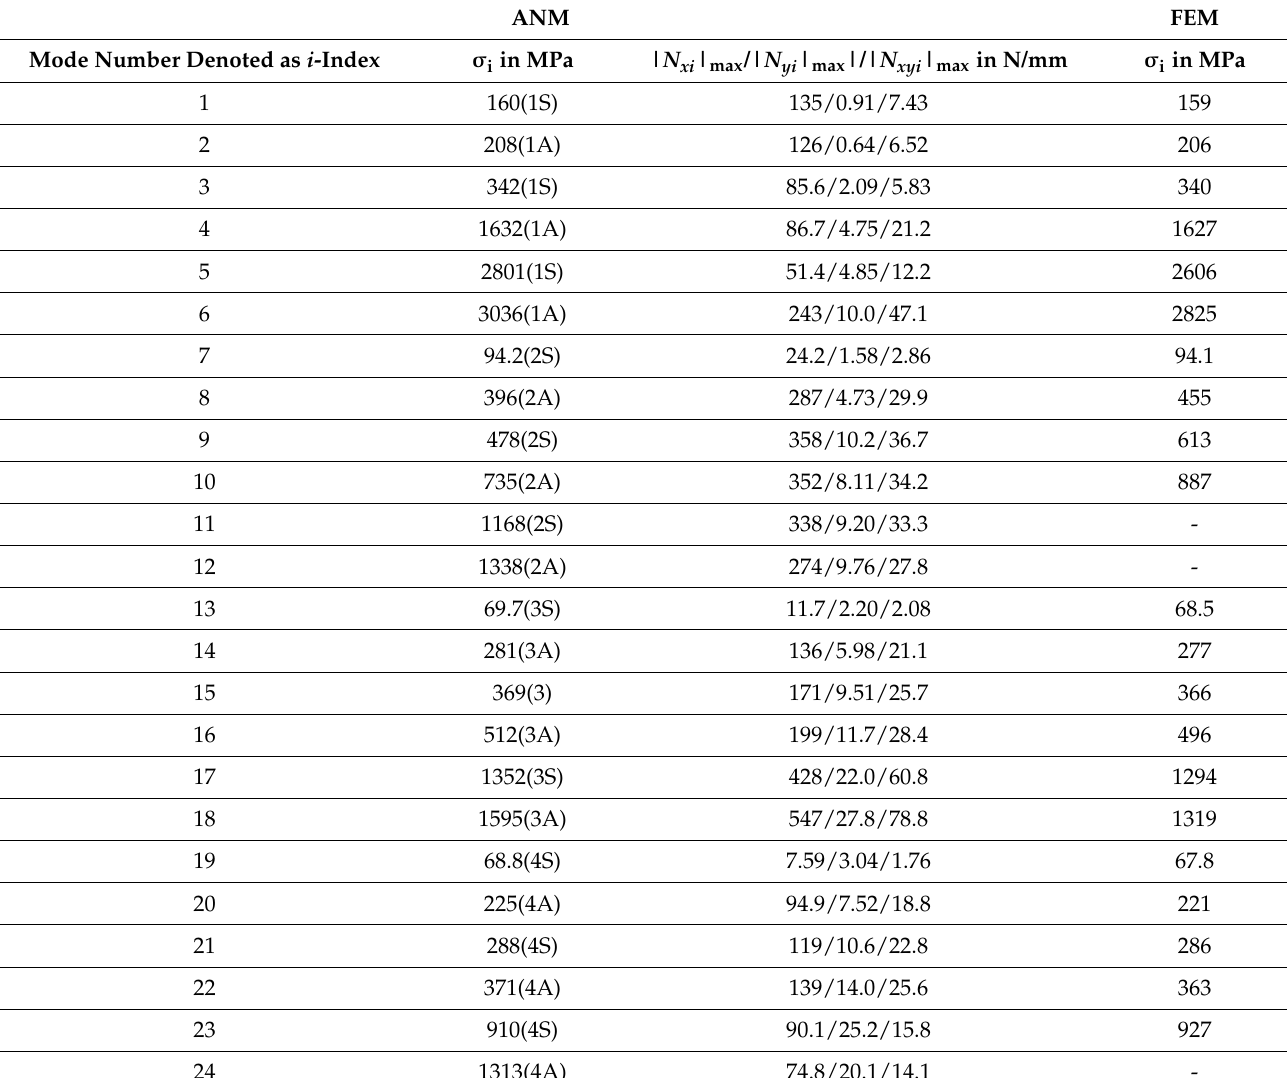
Table 5. Bifurcational stresses (i.e., σ i in MPa) and maximal absolute values of membrane forces in N for selected buckling modes of TH-channels with length L = 225